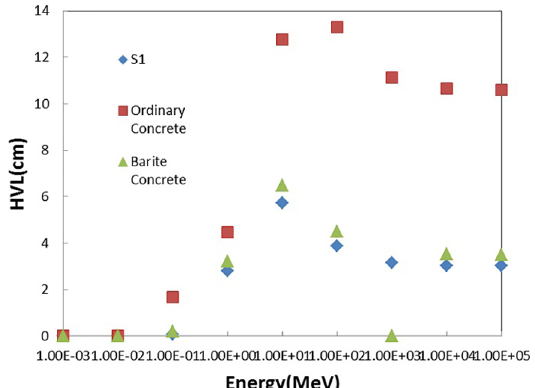
Figure 2. Plot of HVL (cm) for S1 and ordinary and barite concretes as a function of photon energy